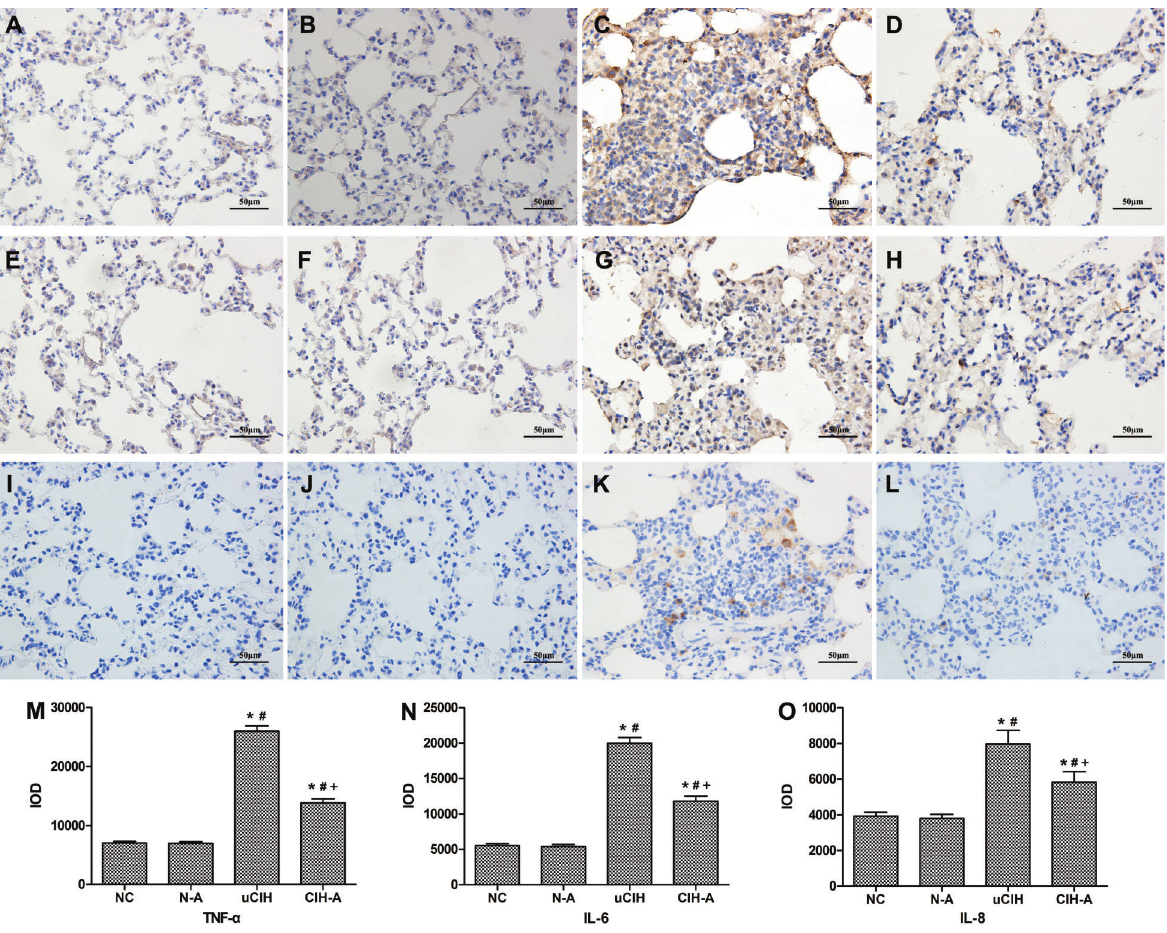
Figure 3. Immunohistochemical expression of TNF- a and IL-6 in rat lungs. A – D , TNF- a ; E – H , IL-6; I – L , IL-8. Representative photomicrographs of lung immunohistochemical analysis (400 (cid:3) , bar 50 m m). Little expression could be seen in alveolar epithelial cells, and in fl ammatory cells in A , E , I (NC group) and B , F , J (N-A group). A strong positive expression occurred in C , J , K (uCIH group) and staining intensity was attenuated in D , H , L (CIH-A group). M – O , comparison of integrated optical density (IOD) values among the 4 groups: M , TNF- a ; N , IL-6; O , IL-8. Data are reported as means ± SE. NC: normoxia control group (n=8); N-A: NC and Ang-(1 – 7) supplemented group (n = 8); uCIH: untreated chronic intermittent hypoxia group (n = 8); CIH-A: CIH and Ang-(1 – 7) supplemented